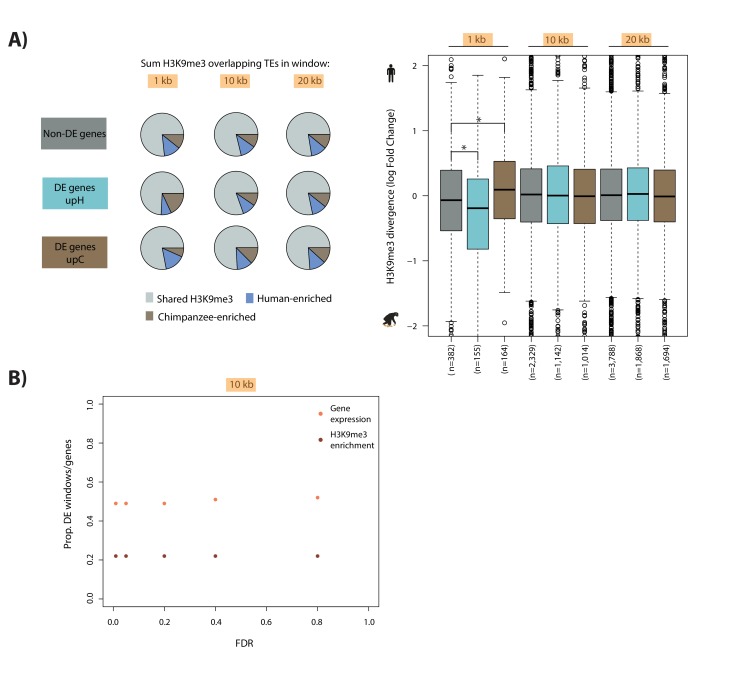
Genes that are differentially expressed between human and chimpanzee are not associated with inter-species differences in H3K9me3 enrichment at TEs distal to the TSS.(A) Genes are stratified into three classes: those that are similarly expressed between humans and chimpanzees (dark grey), those that are up-regulated in human at FDR < 1% (turquoise), and those that are up-regulated in chimpanzee at FDR < 1% (dark brown). The proportion of TEs marked by H3K9me3 in 1, 10, 20 kb windows upstream of the TSS that are shared, enriched in human and enriched in chimpanzee are represented as pie charts. Box plots represent human-chimpanzee divergence of H3K9me3 enrichment overlapping TEs for each gene category in each window. (B) Proportion of genes that are differentially expressed between species when varying the FDR threshold to identify differentially enriched H3K9me3 windows 10 kb upstream of genes (orange). Proportion of H3K9me3 windows 10 kb upstream of genes that are differentially enriched between species when varying the threshold to identify differentially expressed genes (red). Asterisk denotes a significant difference between categories (Wilcoxon-rank sum test; p<0.01).